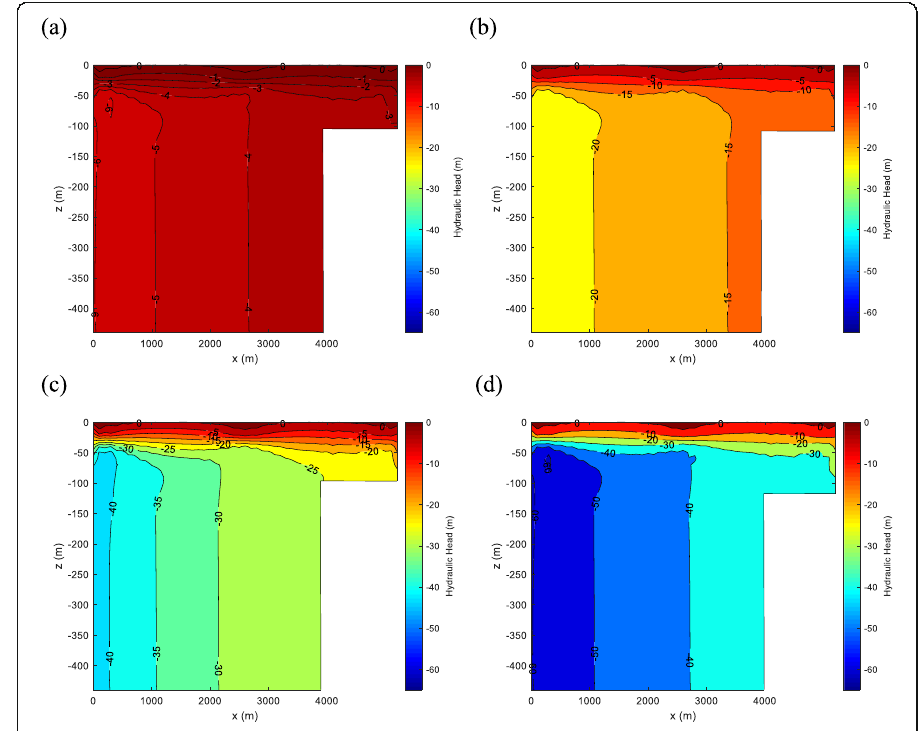
Fig. 5 Deterministic results of the hydraulic head. a Year 1. b Year 4. c Year 7. d Year 10